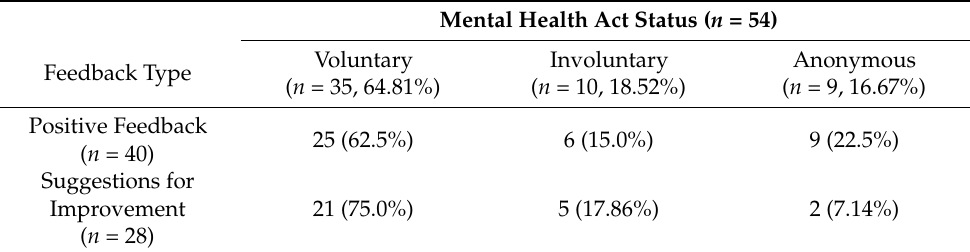
Table 7. Cross-Tabulation of Qualitative Feedback Type by Voluntary Admission